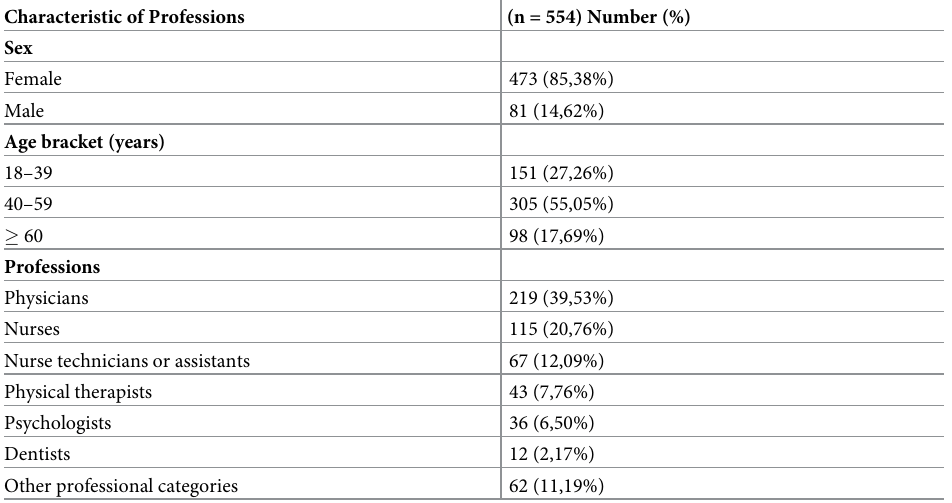
Table 1. The characteristics of the participants included in the study. Characteristic of Professions (n = 554) Number (%)